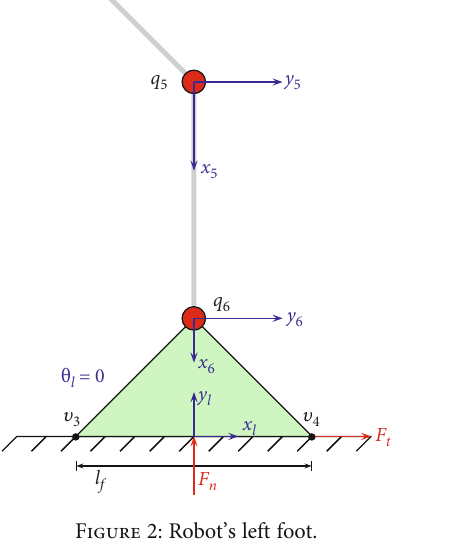
Figure 2: Robot ’ s left